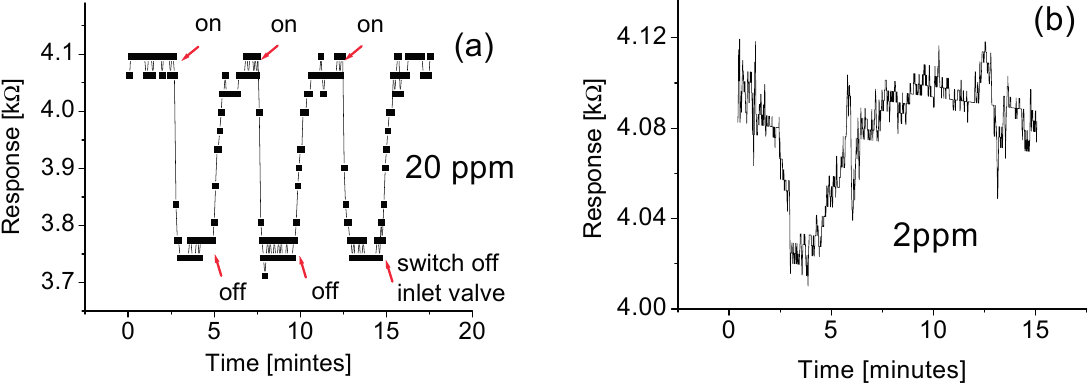
Figure 9. Responses of the sensor to the hydrogen gas at room temperature with the concentration of ( a ) 20 ppm; and ( b ) 2